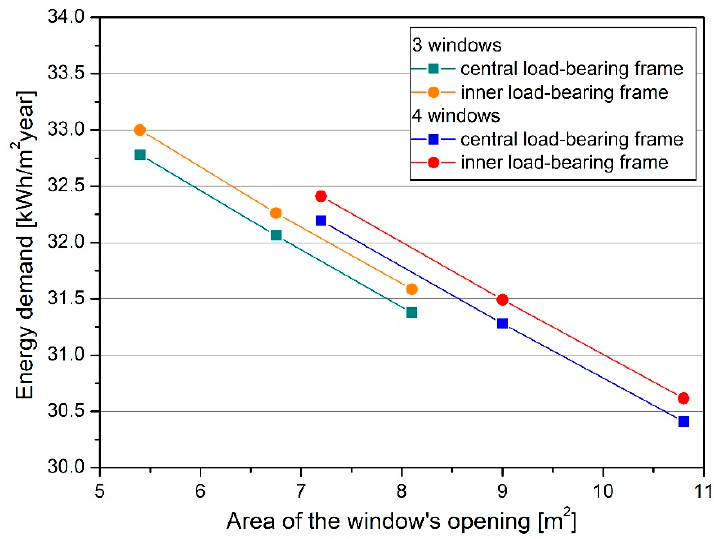
Figure 9. Energy demand depending on the area of the window’s opening. For the same window area, the smaller number of openings is more beneficial from an energy point of view, as the length of the thermal bridges is smaller. Additionally, the non-glazed, composite-insulated partition is characterized by a lower heat transfer coefficient than the window, which means that heat loss is